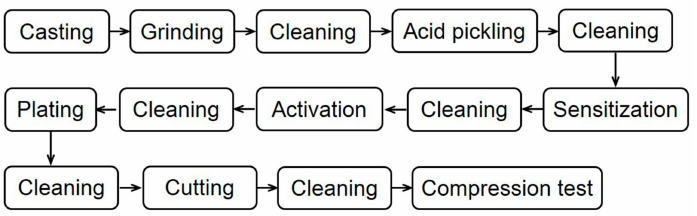
Figure 1. The process diagram of the electroless Ni